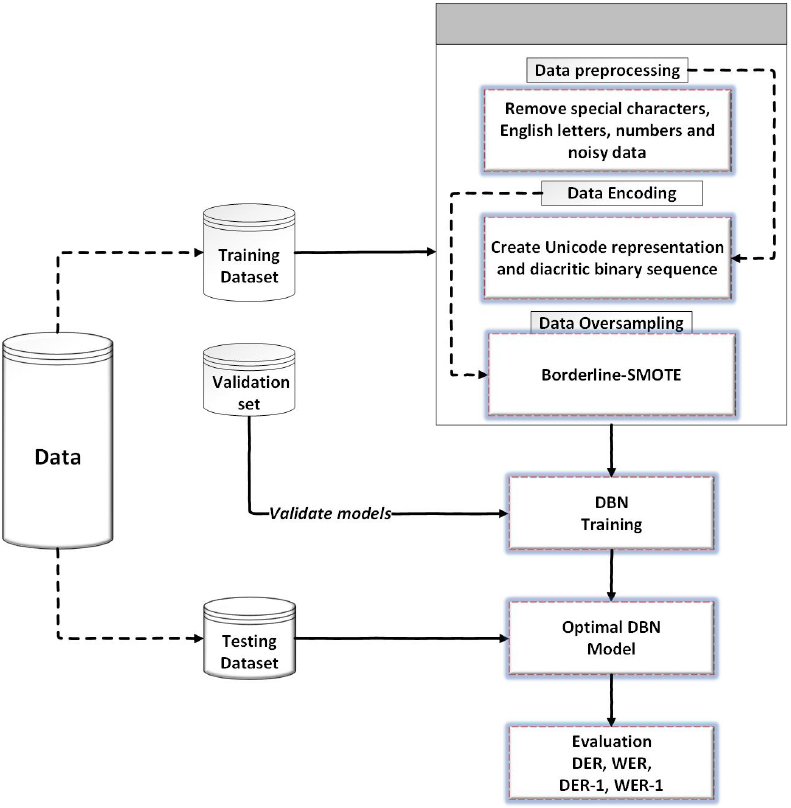
Figure 3. The main steps followed in the proposed